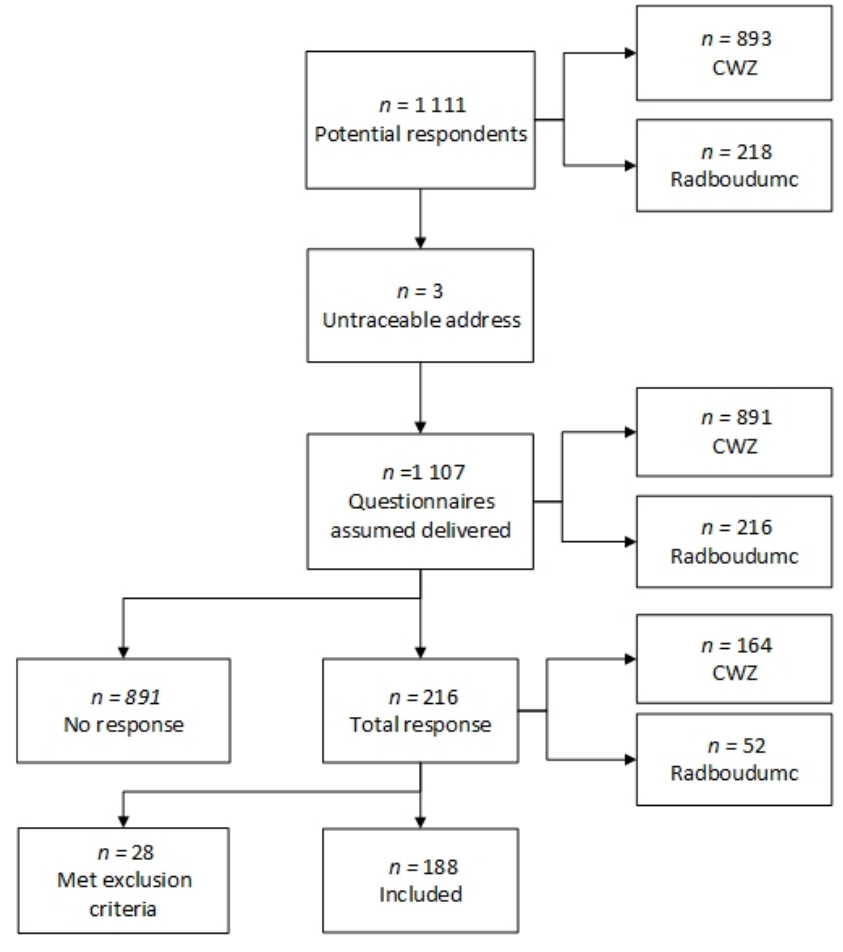
Figure 1. Flowchart of the patient inclusion process. Table 1. Baseline characteristics for included respondents vs. non ‐ respondents.